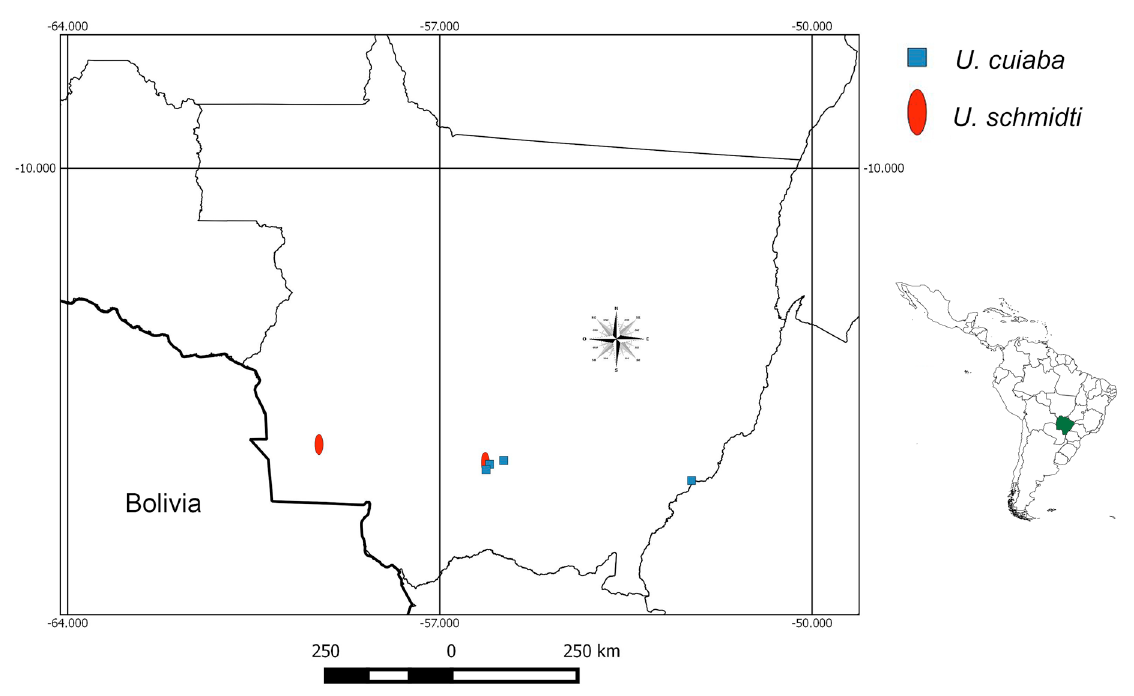
Fig. 31. Geographic distribution records of species of Umbyquyra gen. nov.: U. cuiaba gen. et sp. nov. and U . schmidti (Rudloff, 1996) gen. et comb.